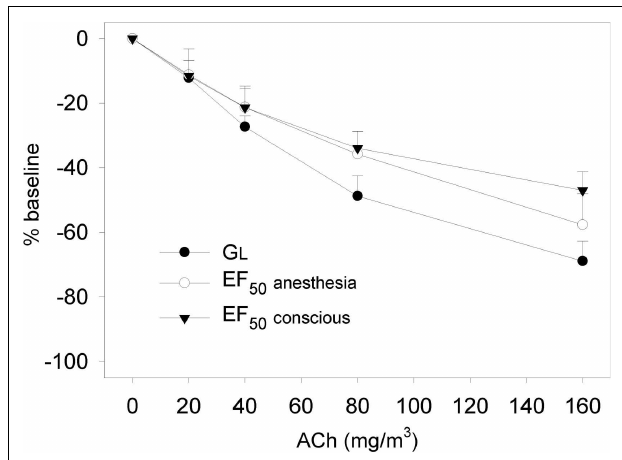
FIGURE 4 | Dose-response relationship to aerosolized acetylcholine chloride (ACh; 20–160mg/m 3 ) in naive Brown Norway rats. Non-invasive determination of the decline in EF 50 to ACh was followed by invasive recording of simultaneously measured decreases in EF 50 and G L ( G L = 1/R L ) to ACh exposure in the same animals 24h later. EF 50 and G L were allowed to return to baseline before each subsequent challenge. Results are means ± SD ( n = 8 rats) of percent changes to corresponding baseline values, which were taken as 0%. No significant differences in dose-related changes were observed between non-invasively and invasively measured EF 50 . [reprinted with permission from Glaab et al.